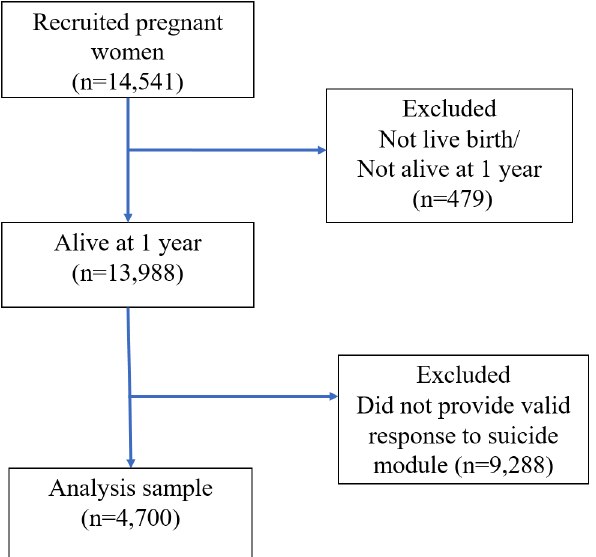
Fig 2. Study population and analysis cohort, ALSPAC CONSORT flow diagram, United Kingdom,